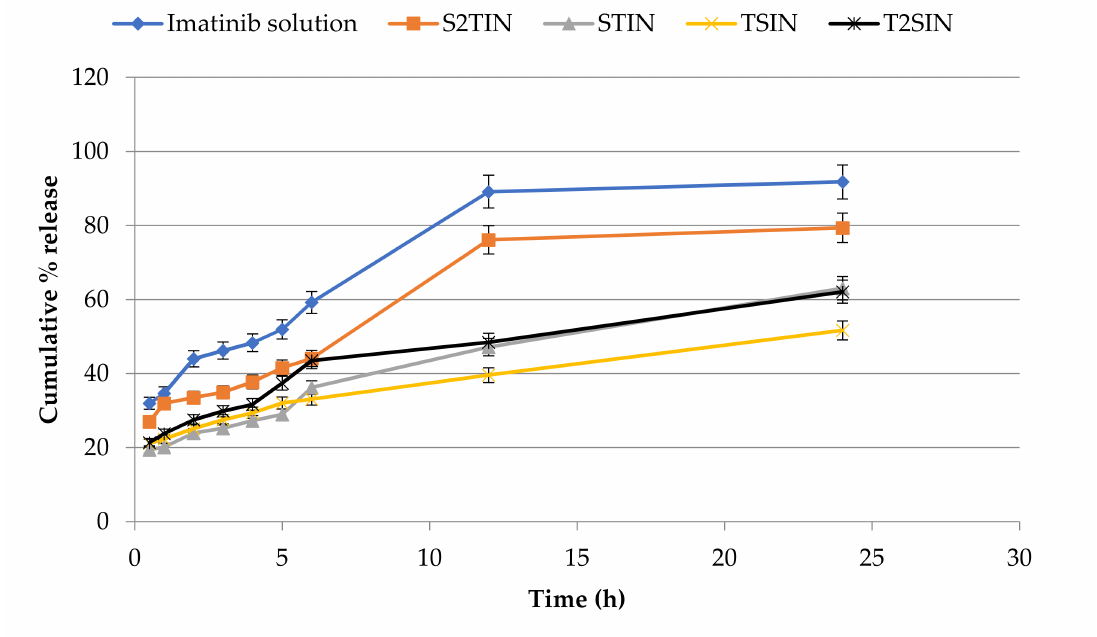
Figure 4. In vitro release pattern of the NANIMA